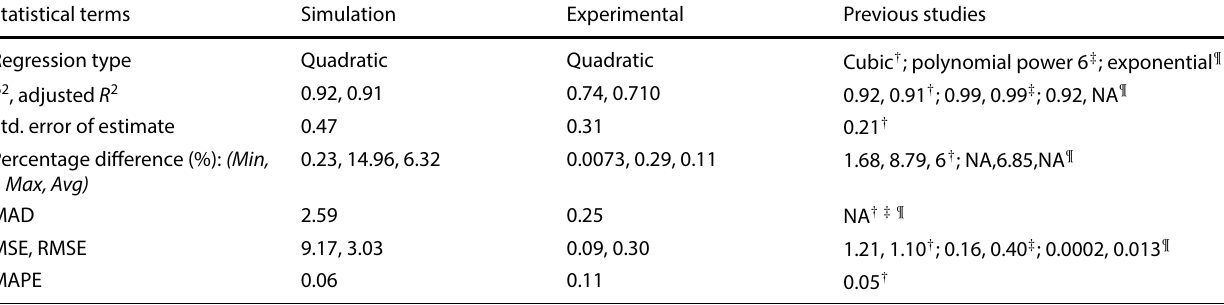
Table 4 Comparison of curve fitting statistical analysis for P out